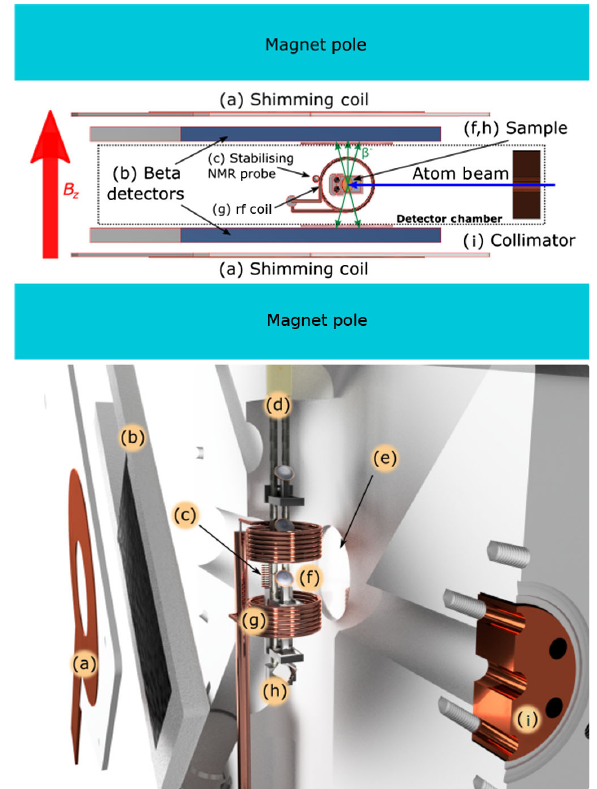
FIG. 2. β -NMR detection chamber. Top: Schematic cross sec- tion as viewed from the top. Bottom: 3D CAD exploded view. (a) Shimming coil to improve field homogeneity; (b) β -particle detector (plastic scintillator) and Si photomultiplier; (c) 1 H-NMR probe to monitor and actively stabilize the magnetic field; (d) sample ladder; (e) β -particle window ( 100 μ m aluminum); (f) mica sample holder; (g) main rf coil for NMR excitations; (h) NaF crystal to optimize the degree of laser spin polarization; (i) 8-mm beam collimator. See the text for further